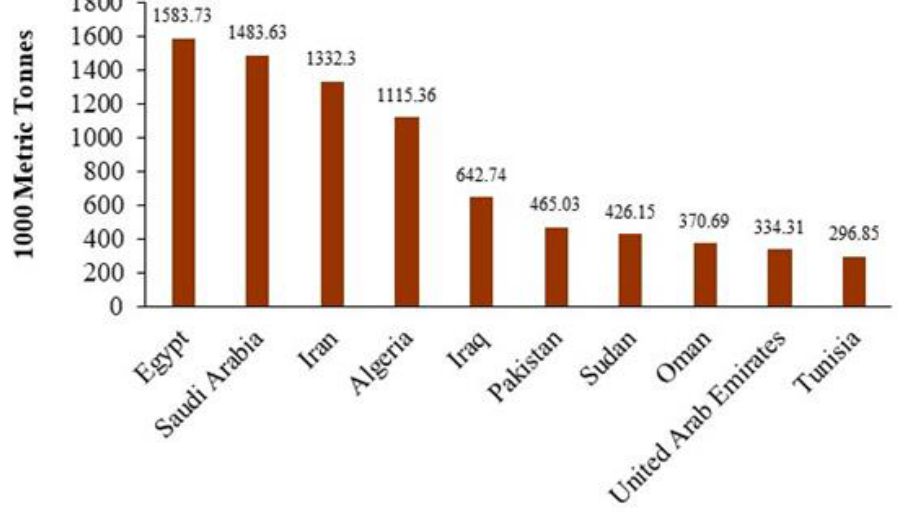
Figure 1. Top 10 date-producing countries (FAOSTAT, 2018 and 2019).